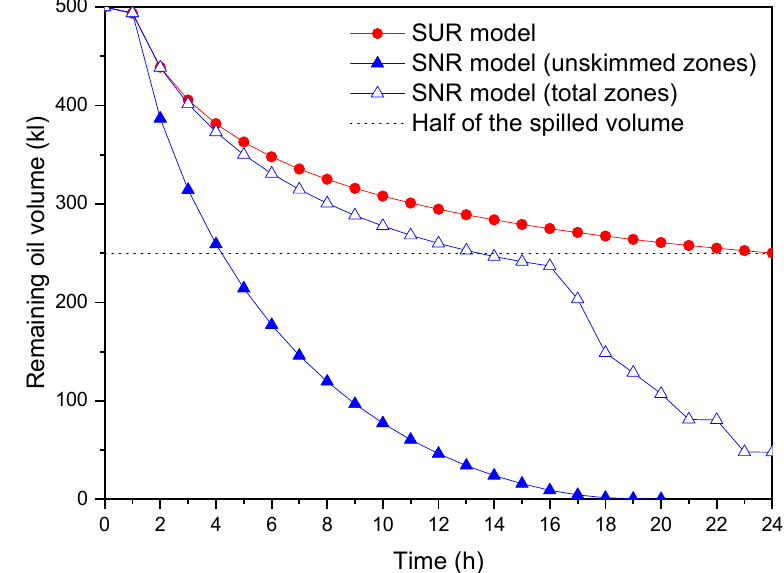
Figure 11. Comparison of the remaining oil volume of the SUR model and unskimmed zone and total zone in the SNR model.